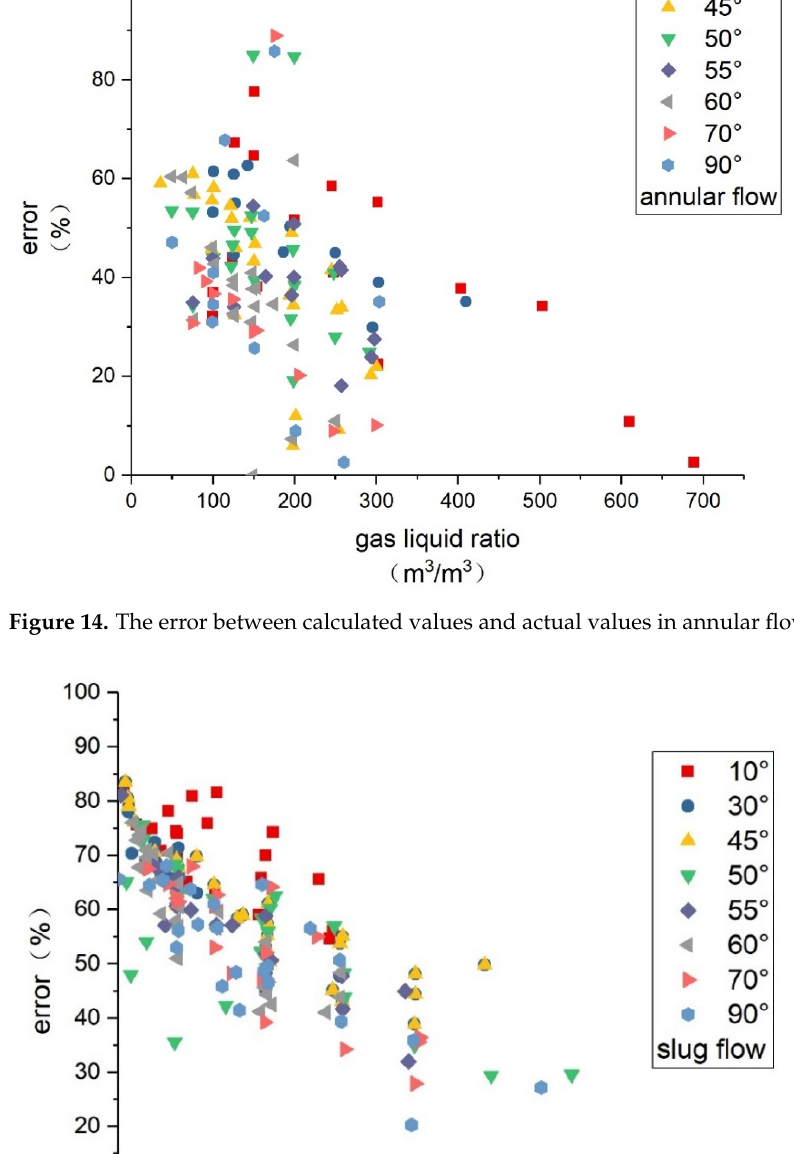
Figure 15. The error between calculated values and actual values in slug flow.